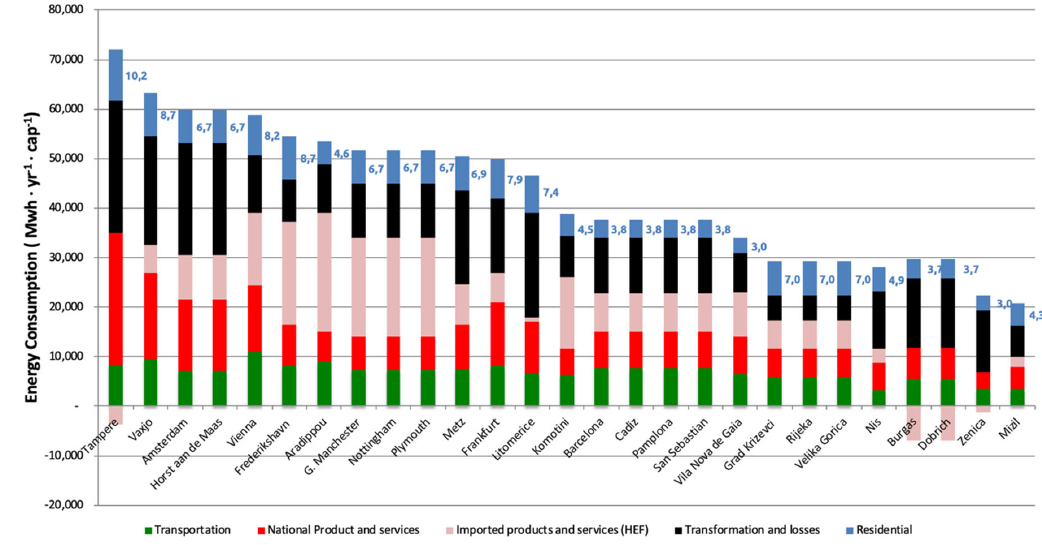
Figure 6. National energy consumptions by sector.